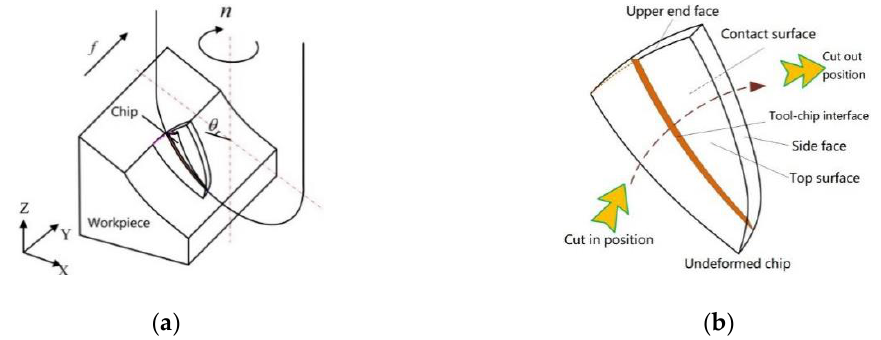
Figure 14. Schematic diagram of the milling process: ( a ) Milling of Inclined Plane; ( b ) Schematic of chip shape.